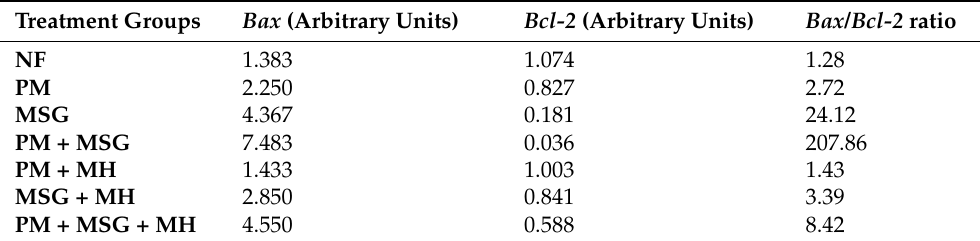
Table 1. Correlation of CD95 sensitivity with the intraexperimental quantification of the Bax / Bcl- 2 ratio. Treatment